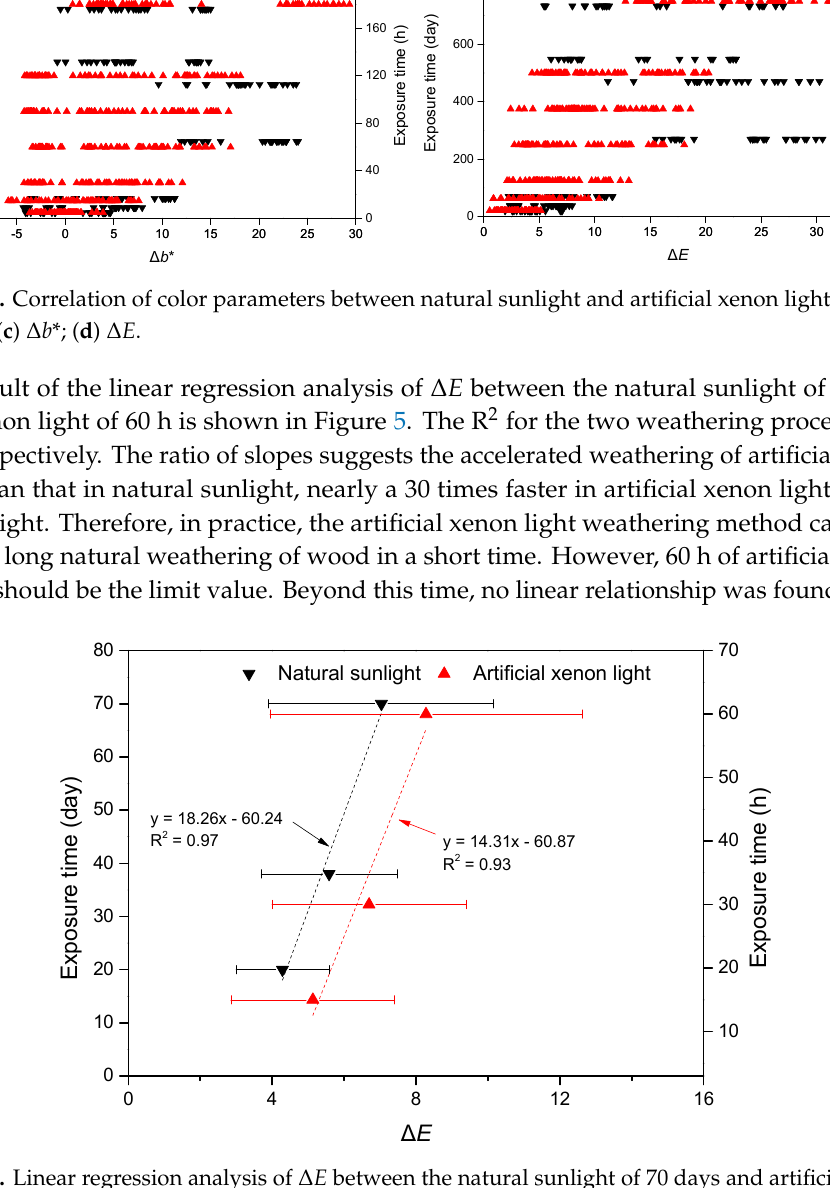
Figure 5. Linear regression analysis of Δ E between the natural sunlight of 70 days and artificial xenon light of 60 h.